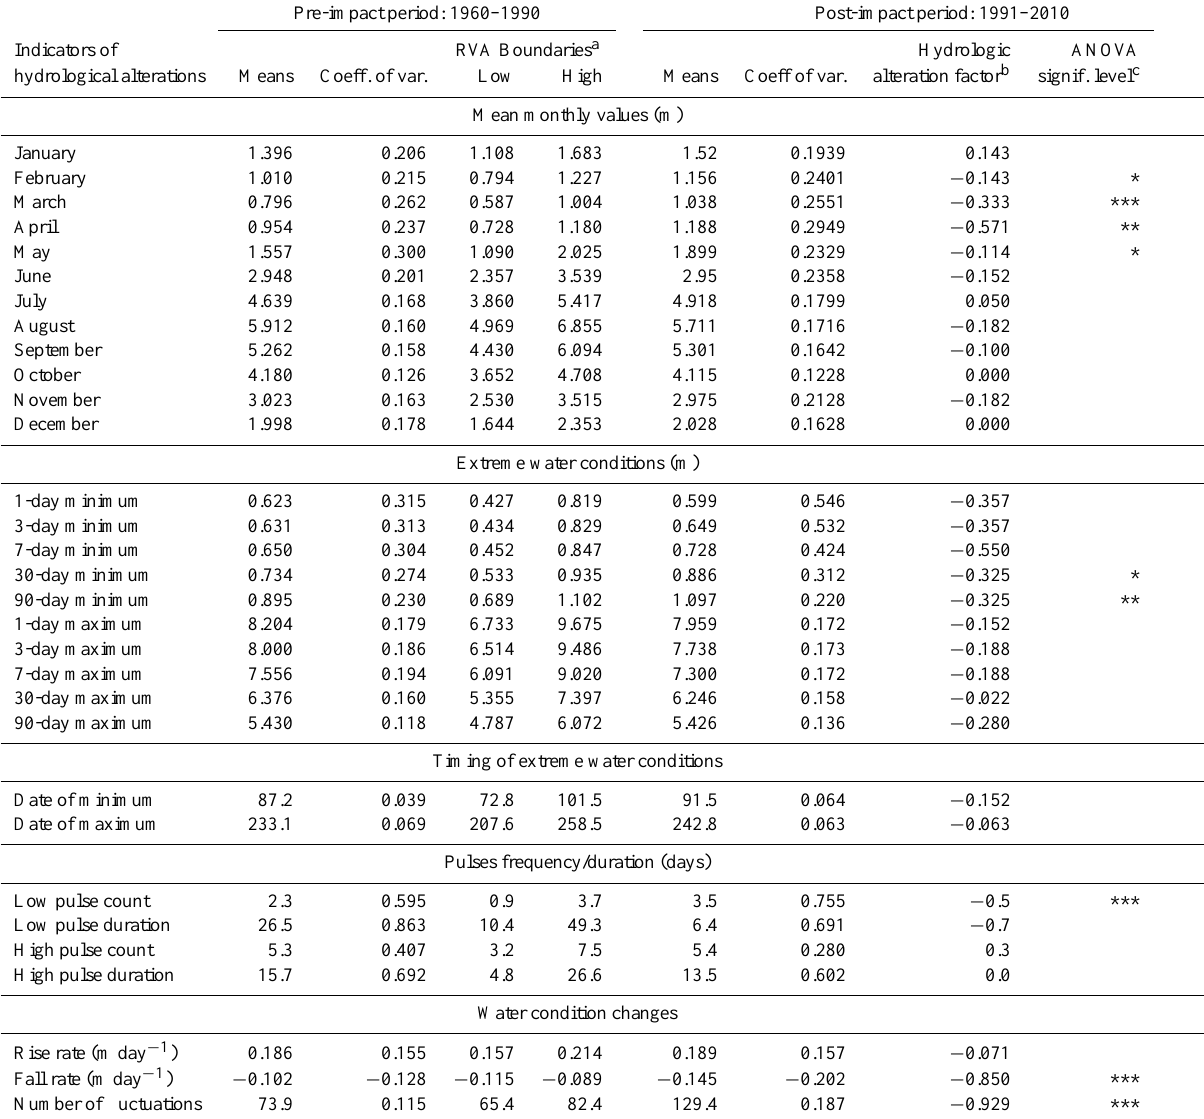
Table 3. Indicators of hydrological alterations and alteration factors (within 1 standard deviation) at Chiang Saen. Pre-impact period: 1960–1990 Post-impact period: